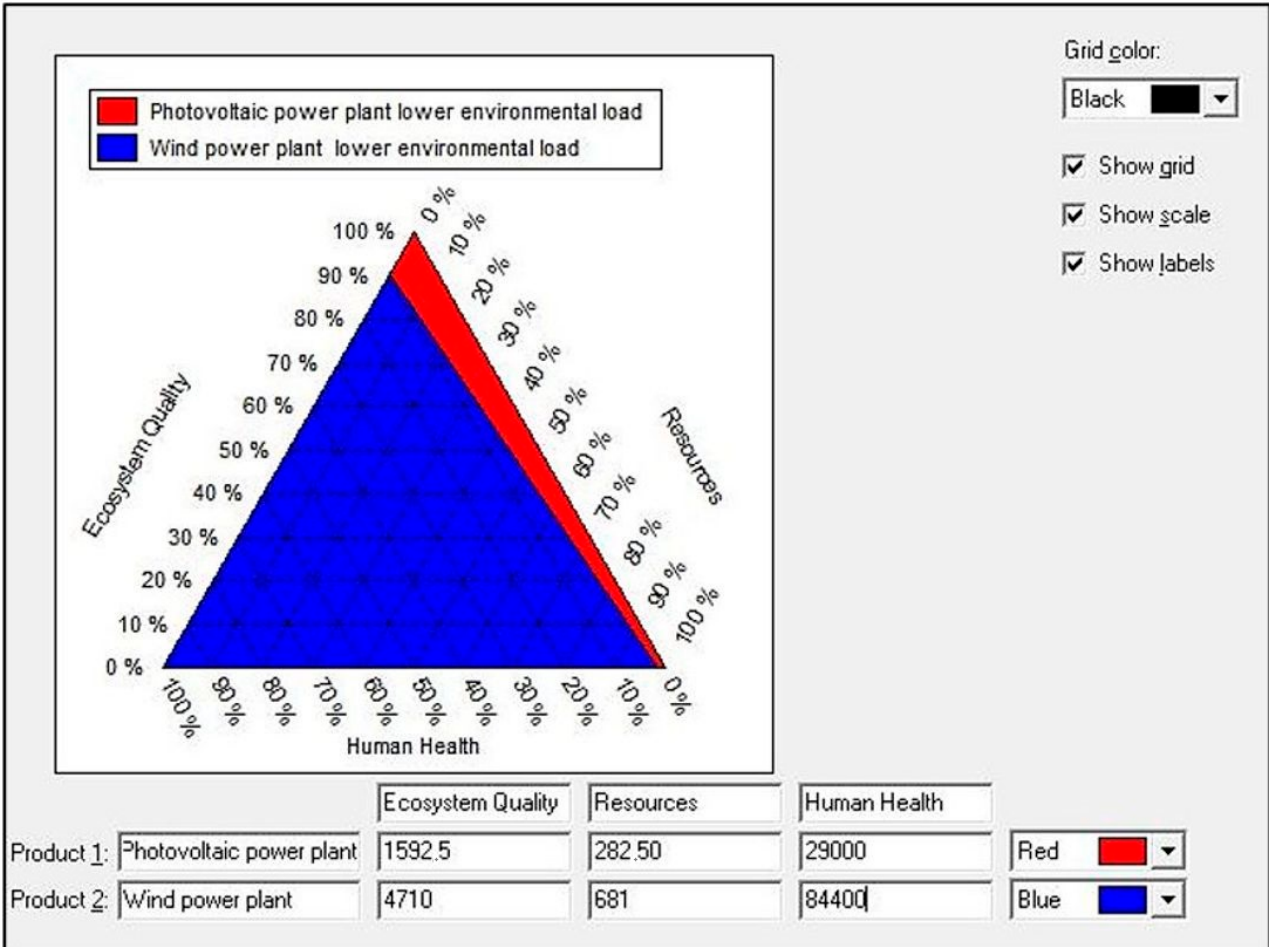
Figure 7. Grouping and weighting results of environmental effects for areas of influence present in the life cycle of wind (W) and photovoltaic (PV) power plants (unit: % and Pt)—triangle view.